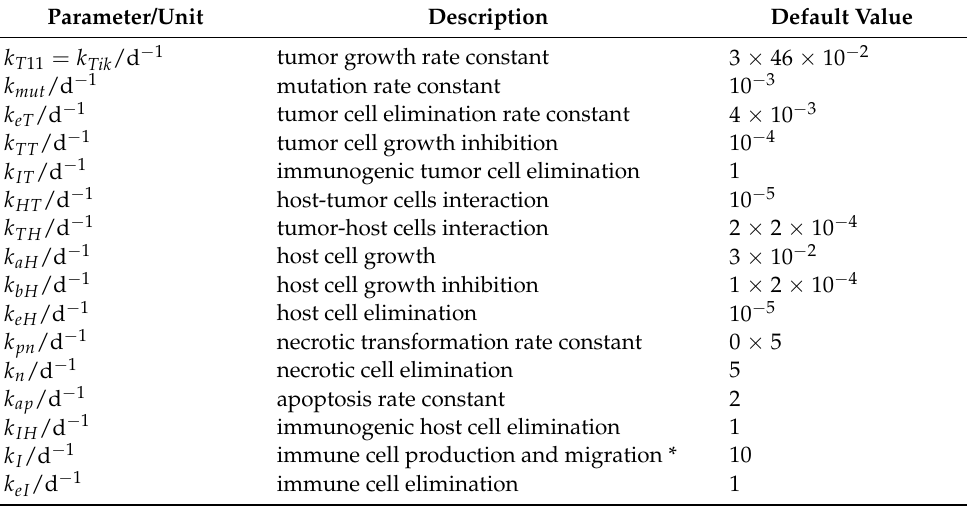
Table 1. Model parameters for ecosystem interactions: parameters used for the investigated scenario; parameters considered as susceptible for hyperthermia are indicated by an asterisk. Parameters are normalized to 10 9